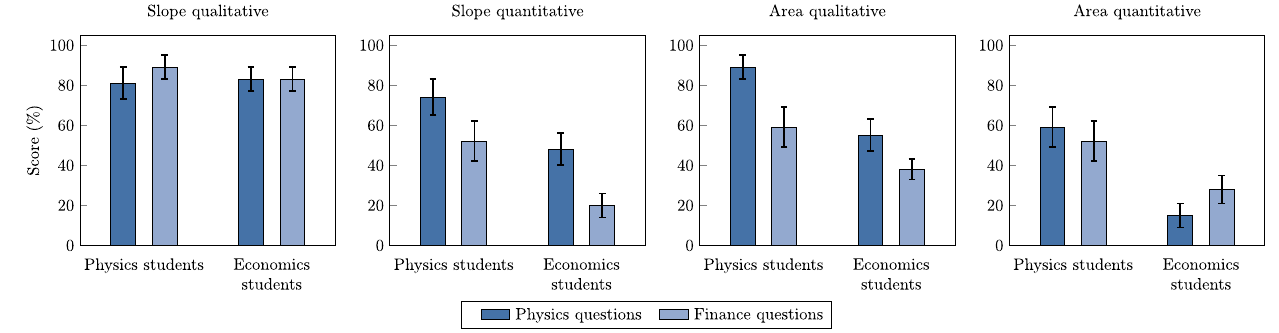
FIG. 4. Average scores of physics and economics students in the context of physics and finance on the qualitative and quantitative questions about graph slope and area under a graph. The error bars represent 1 SEM.